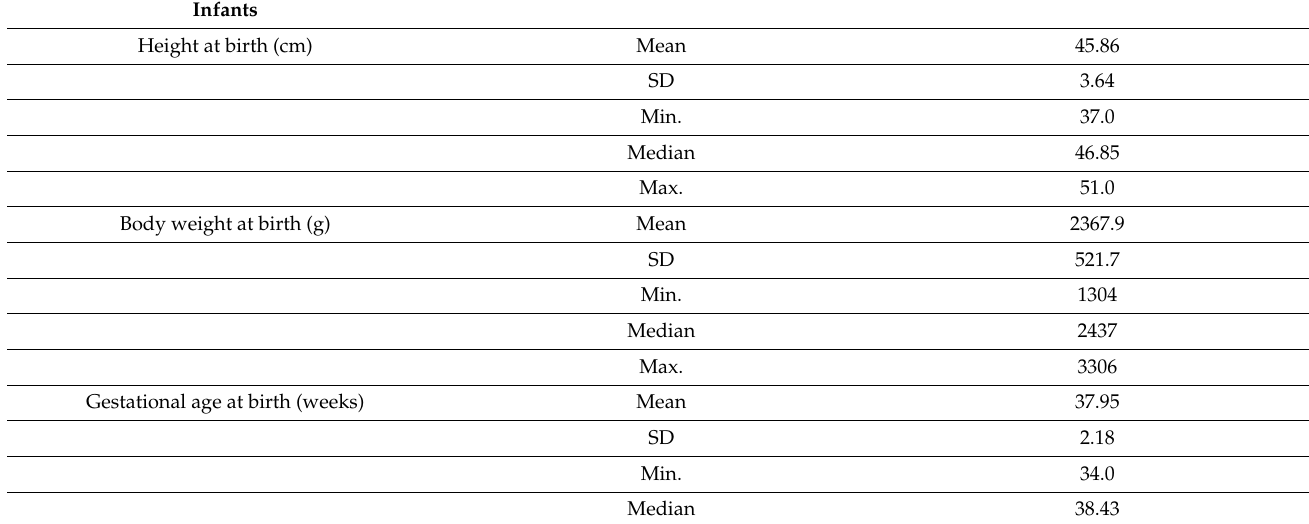
Figure 1. Flowchart showing participant selection for this clinical trial. Table 1. Baseline demographic and clinical characteristics, n = 24.